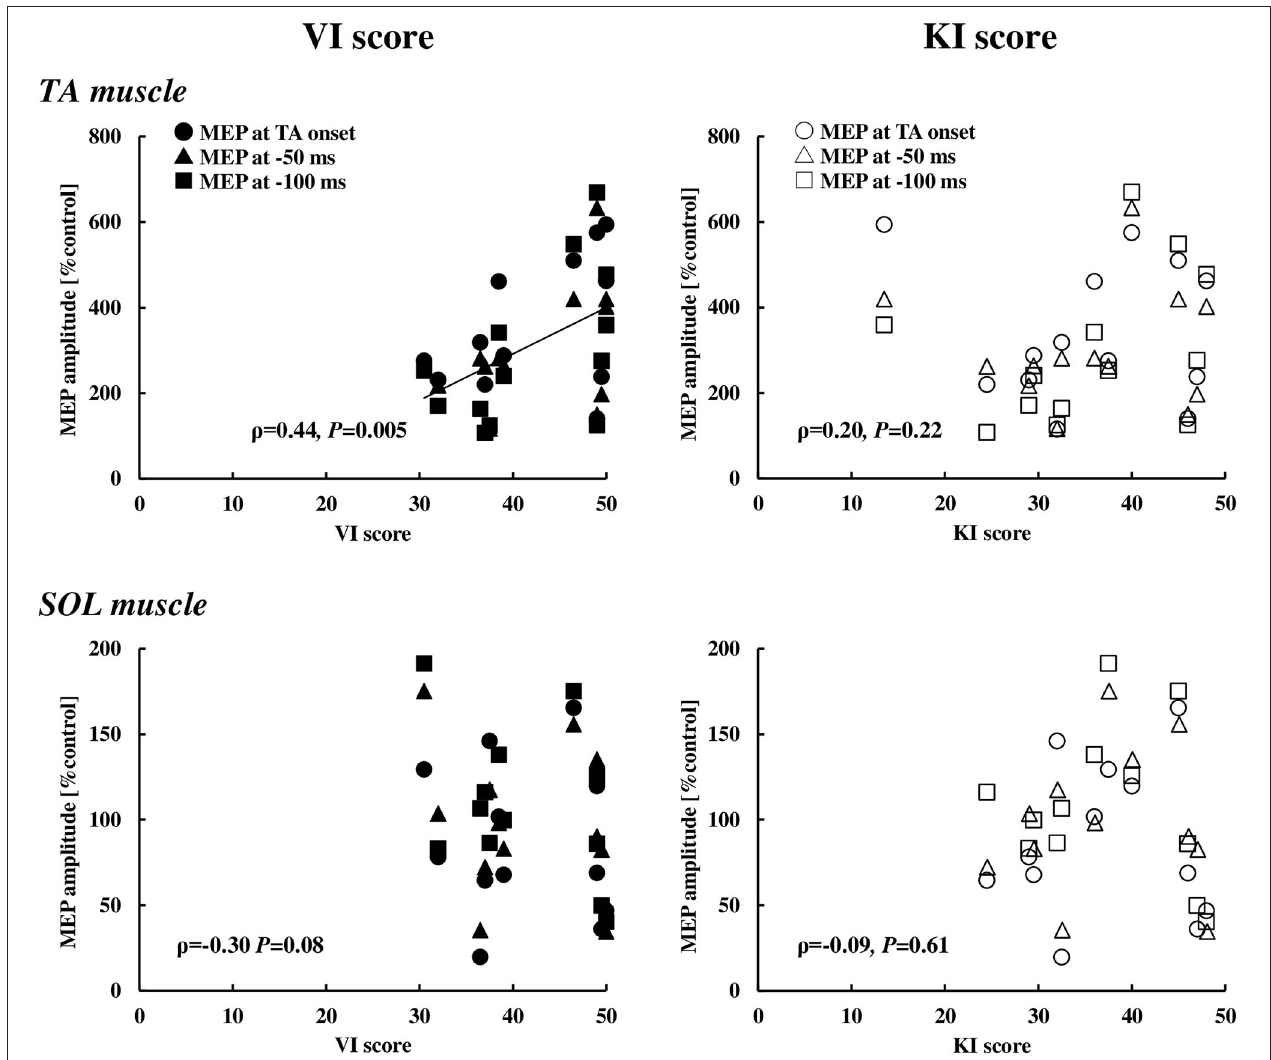
FIGURE 6 | Relationships between the VI or KI score and the MEP in the TA ( n = 13) and SOL ( n = 12) muscles at the timings of 0, 50, and 100ms prior to the EMG onset of the TA muscle. VI, visual imagery; KI, kinesthetic imagery; TA, tibialis anterior; SOL, soleus, MEP, motor evoked